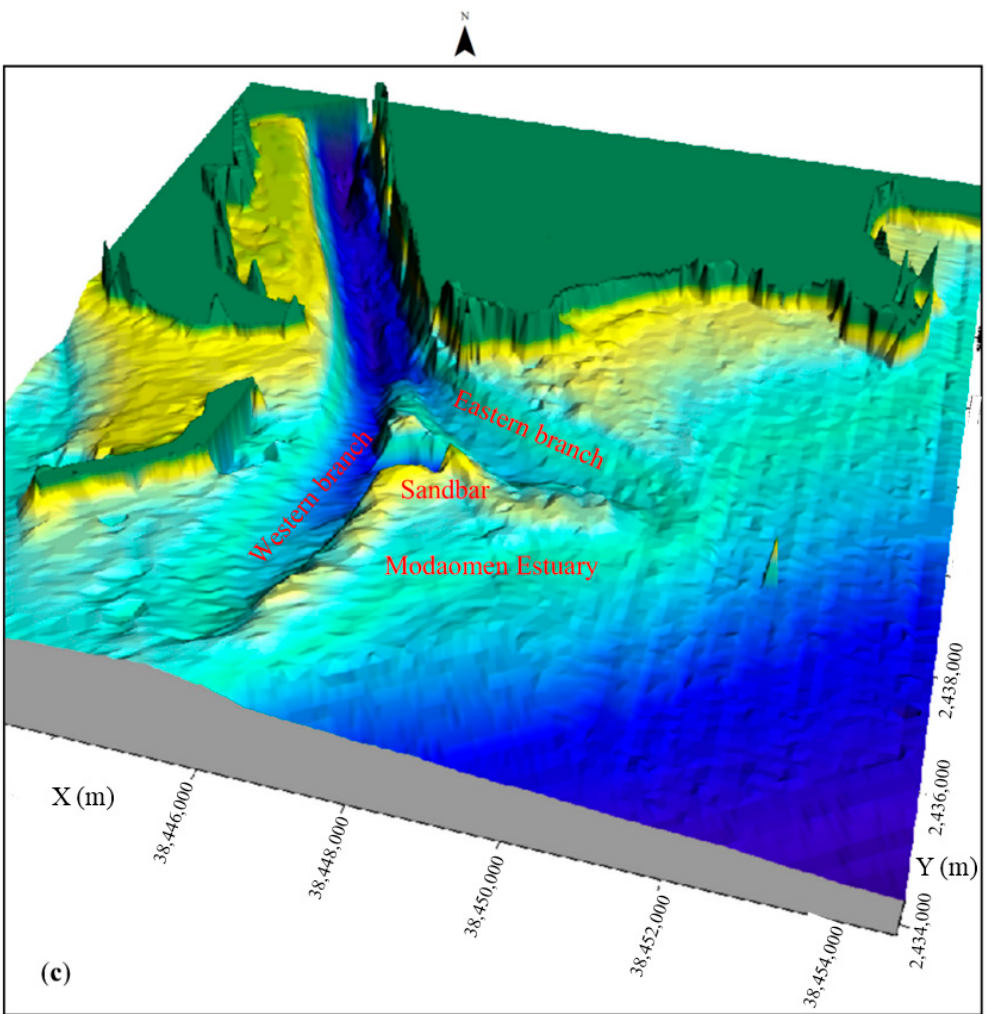
Figure 10. The sandbar in Modaomen Estuary. ( a )The simulated thickness of deposition and scour; ( b ) The annual average change of the measured terrain from 2005 to 2011; ( c ) The measured terrain in 2011.